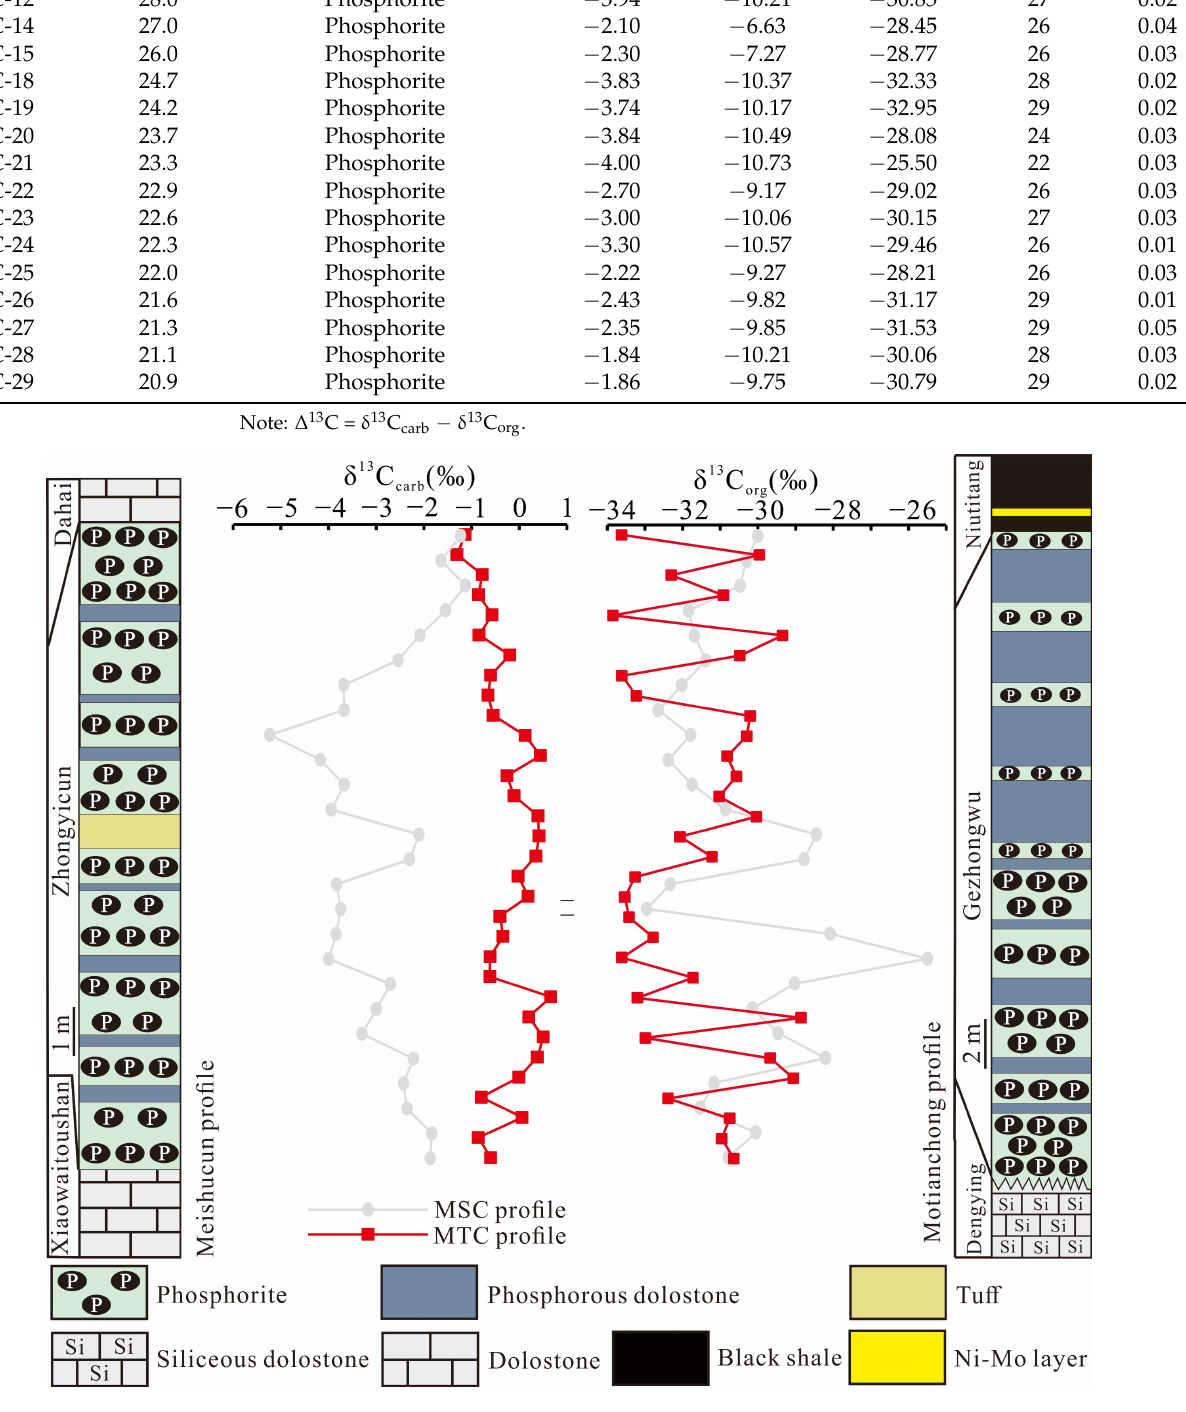
Figure 4. δ 13 C carb and δ 13 C org curves from phosphorus rock series in Motianchong (MTC) and Meishucun (MSC) profiles. MSC data were obtained from [18]. The concentrations of major elements, trace elements, and REY of the phosphorus rock series from the MTC profile are shown in Table 2 and Table S1. The ∑ REY values of phosphorus-bearing dolostones, phosphorus dolostones, and phosphorites are 137–558 ppm (average = 330 ppm), 481–990 ppm (average = 676 ppm), and 654–1969 ppm (average = 1477 ppm), respectively. In this study, the REY data is normalized by PAAS [27]. The Ce/Ce * of the samples has no correlation with either ∑ REY or Dy N /Sm N (Figure 5c,d), where Ce/Ce * = Ce N /(La N * Pr N ) 1/2 . The Y/Ho of samples exhibits a negative correlation with Al 2 O 3 , Th, Sc, and Zr, respectively (Figure 7). PAAS-normalized REY patterns of phospho- rites exhibit positive La anomalies, negative Ce anomalies, positive Gd anomalies, and HREE depletions (Figure 8). With an increase in the phosphorus content, ∑ REY and TOC also increase in the MTC profile (Figure 9a,b). The ∑ REY and TOC values of MSC phos- phorites are lower than those of MTC phosphorites (Figure 9a,b).